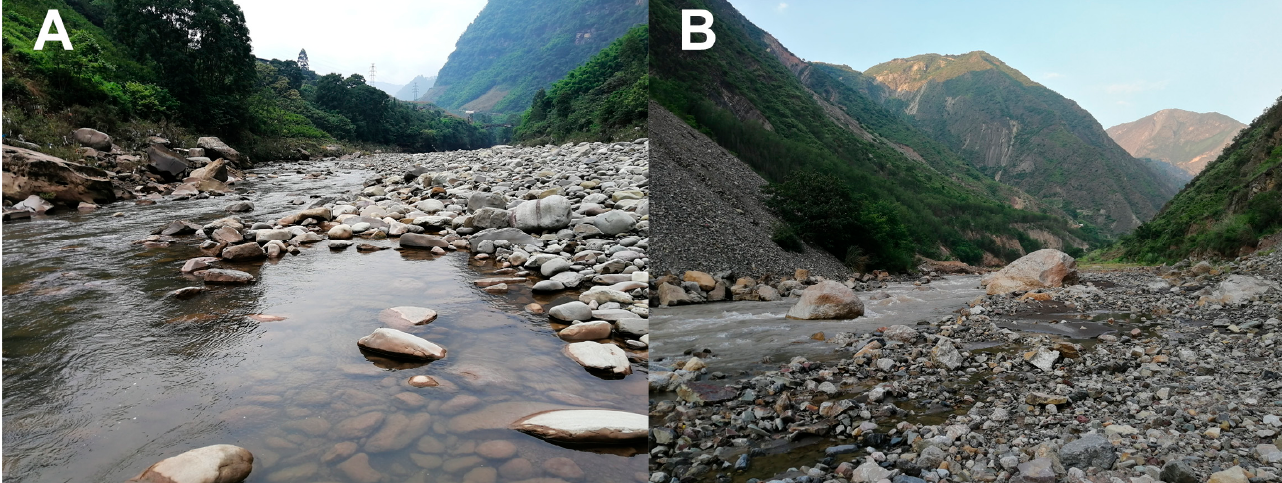
Figure 3. Type locality of Cheumatopsyche latisecta sp. nov. ( A ), Xining River; ( B ), Yili River. Family Ecnomidae Ulmer, 1903